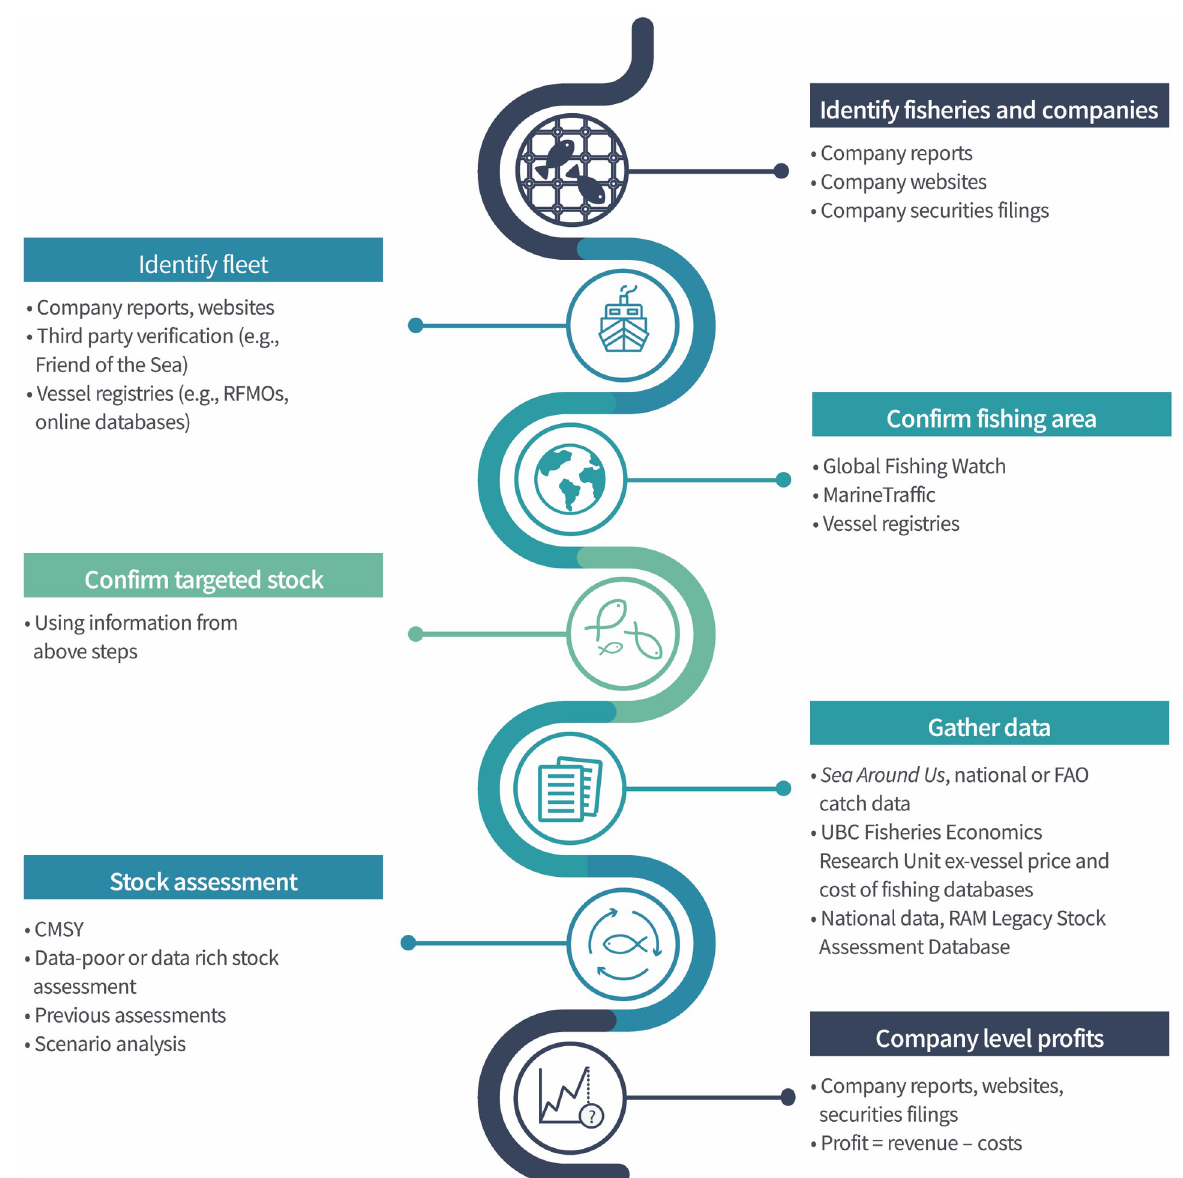
Fig 1. Schematic representation of method for linking fish stocks to company level fisheries revenues and unrealized profits.